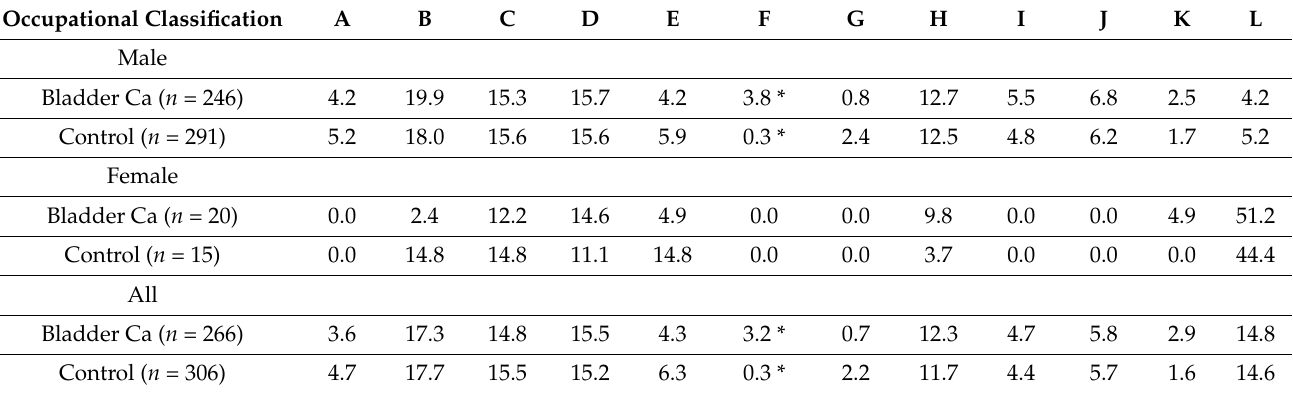
Table 3. Distribution of occupational classification major groups.